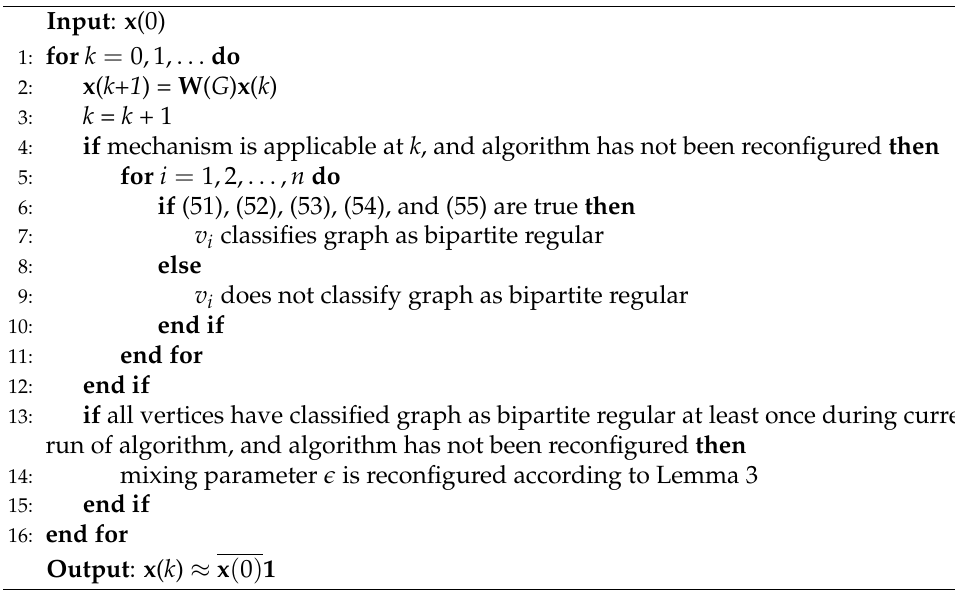
Algorithm 1 AC with MD weights—proposed mechanism is